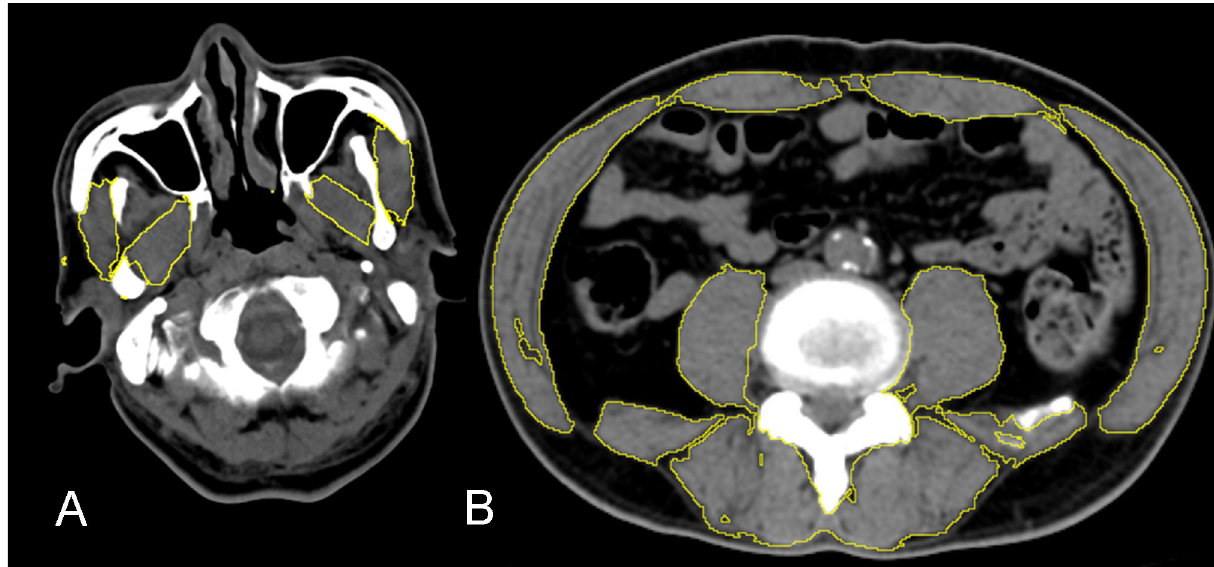
Fig 1. ImageJ delineation of L3 and masticatory muscles with the following threshold setting: − 29 to +150 Hounsfield units. Both images have a clinical soft tissue window setting with a 350-HU width and a 40-HU level. (A) Mandibular notch–level masseter and pterygoid muscle delineations. (B) L3-level muscle CSA